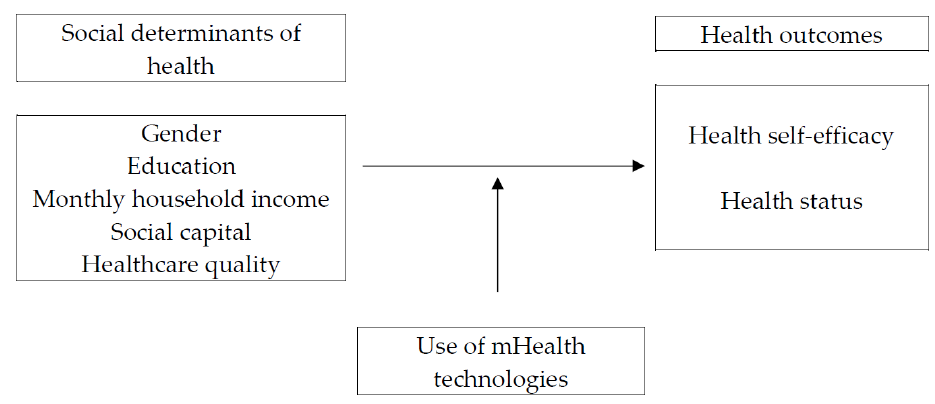
Figure 1. Research framework.